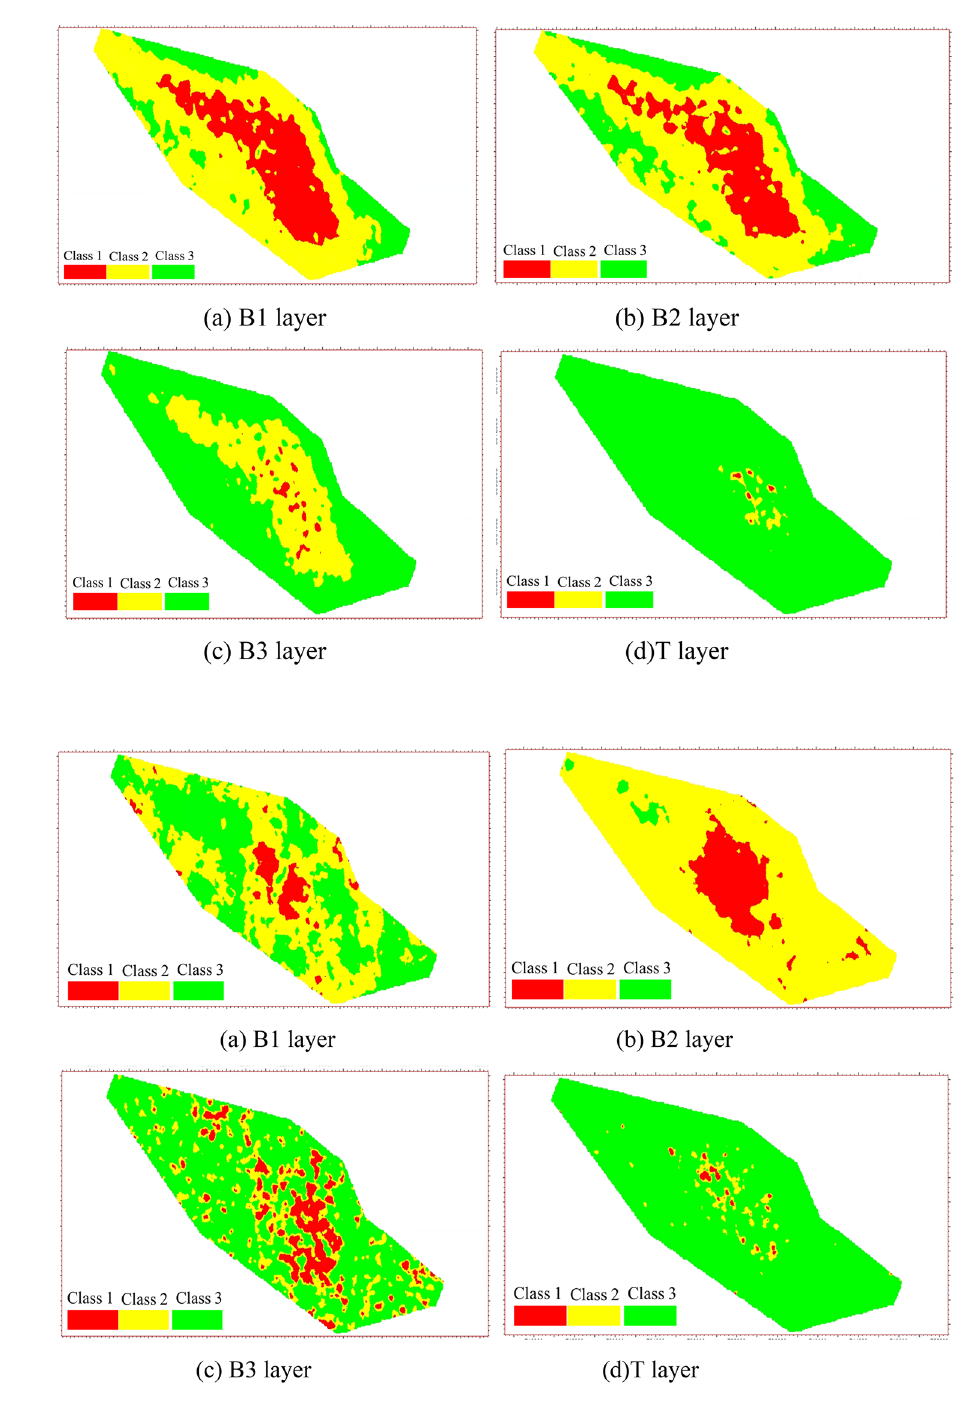
Fig. 19 Distribution of engi- neering sweet spots